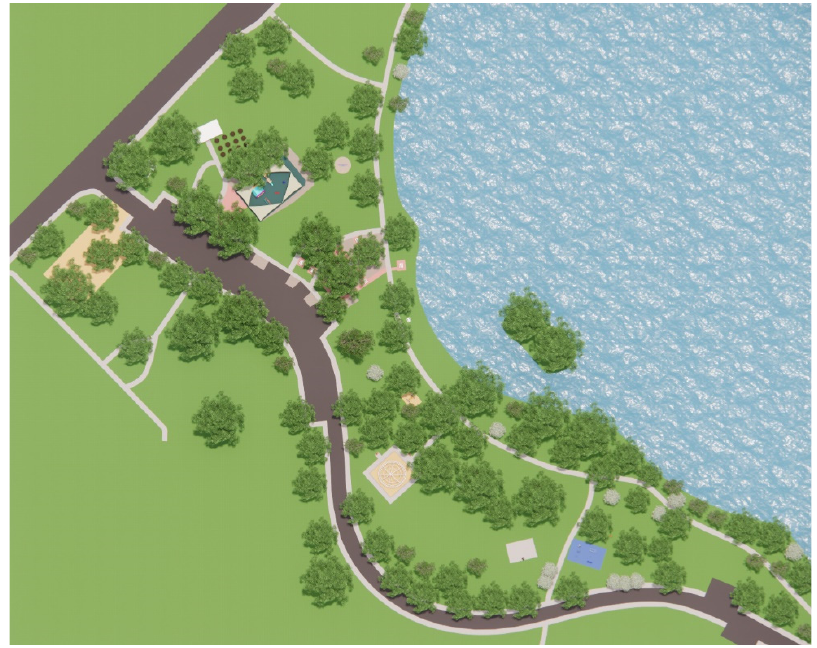
Figure 24. Tomato Lake Playground, Kewdale, at midday on the summer solstice.